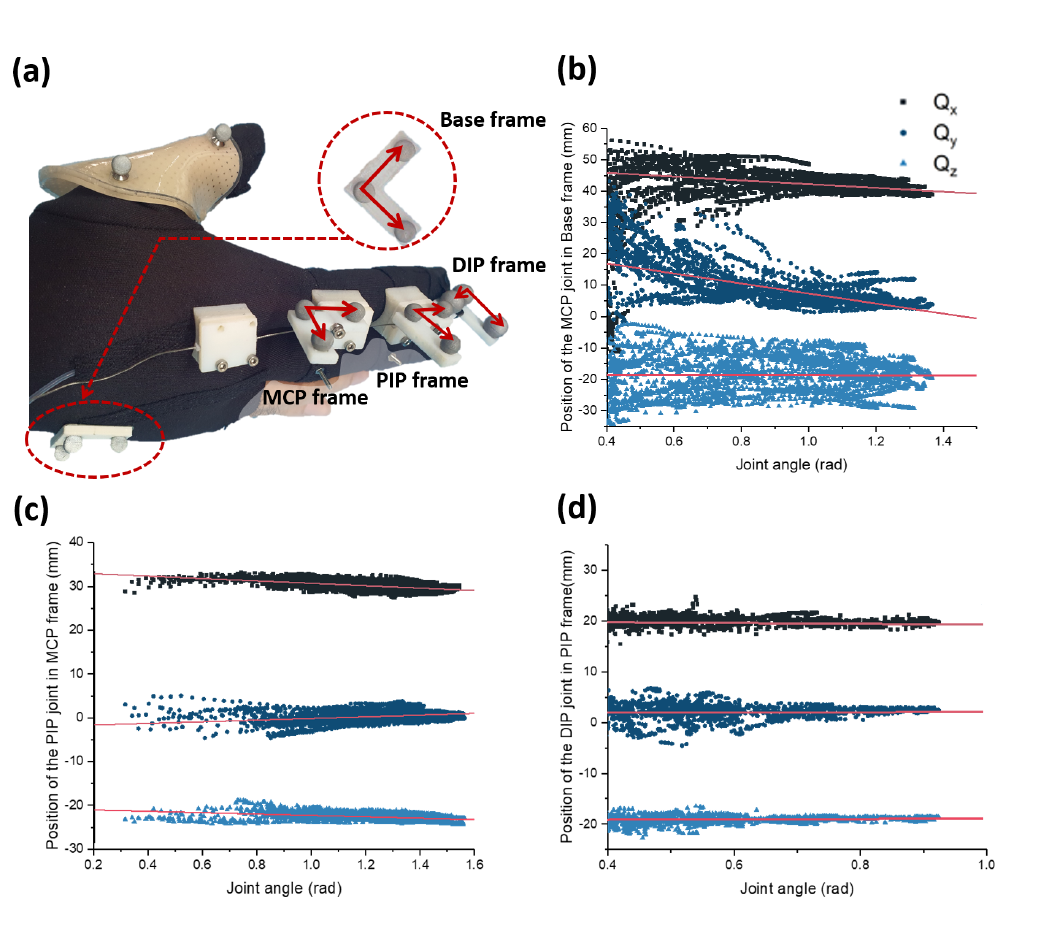
Figure 9. Experimental results about the position of the finger joints found using a vicon motion capture system. ( a ) The marker position used to measure the joint position. With this marker setup, the position of the MCP, PIP, and DIP joint are measured, as shown in ( b – d ). Since the joints move as the joint angle changes, the positions of the joints are expressed in terms of the angle of the